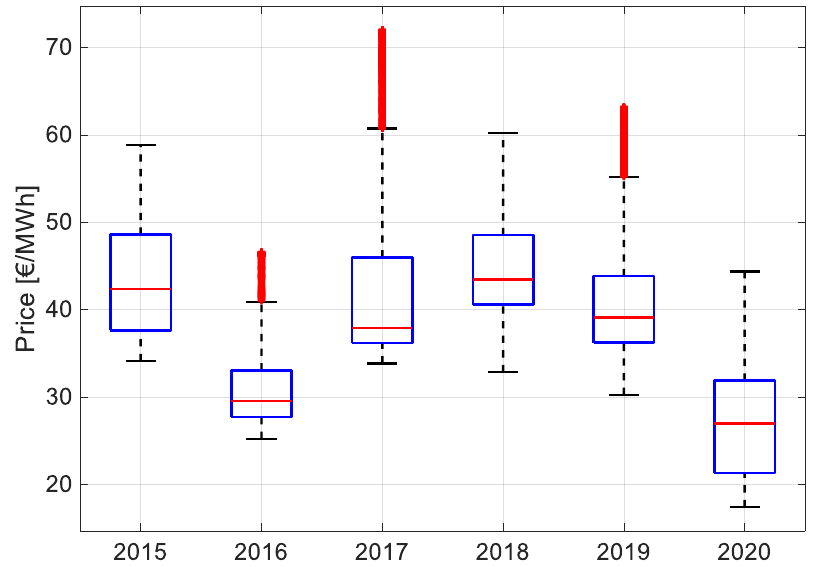
Figure 9. Load-weighted weekly moving pan-European averages of the DAM prices across the selected years.